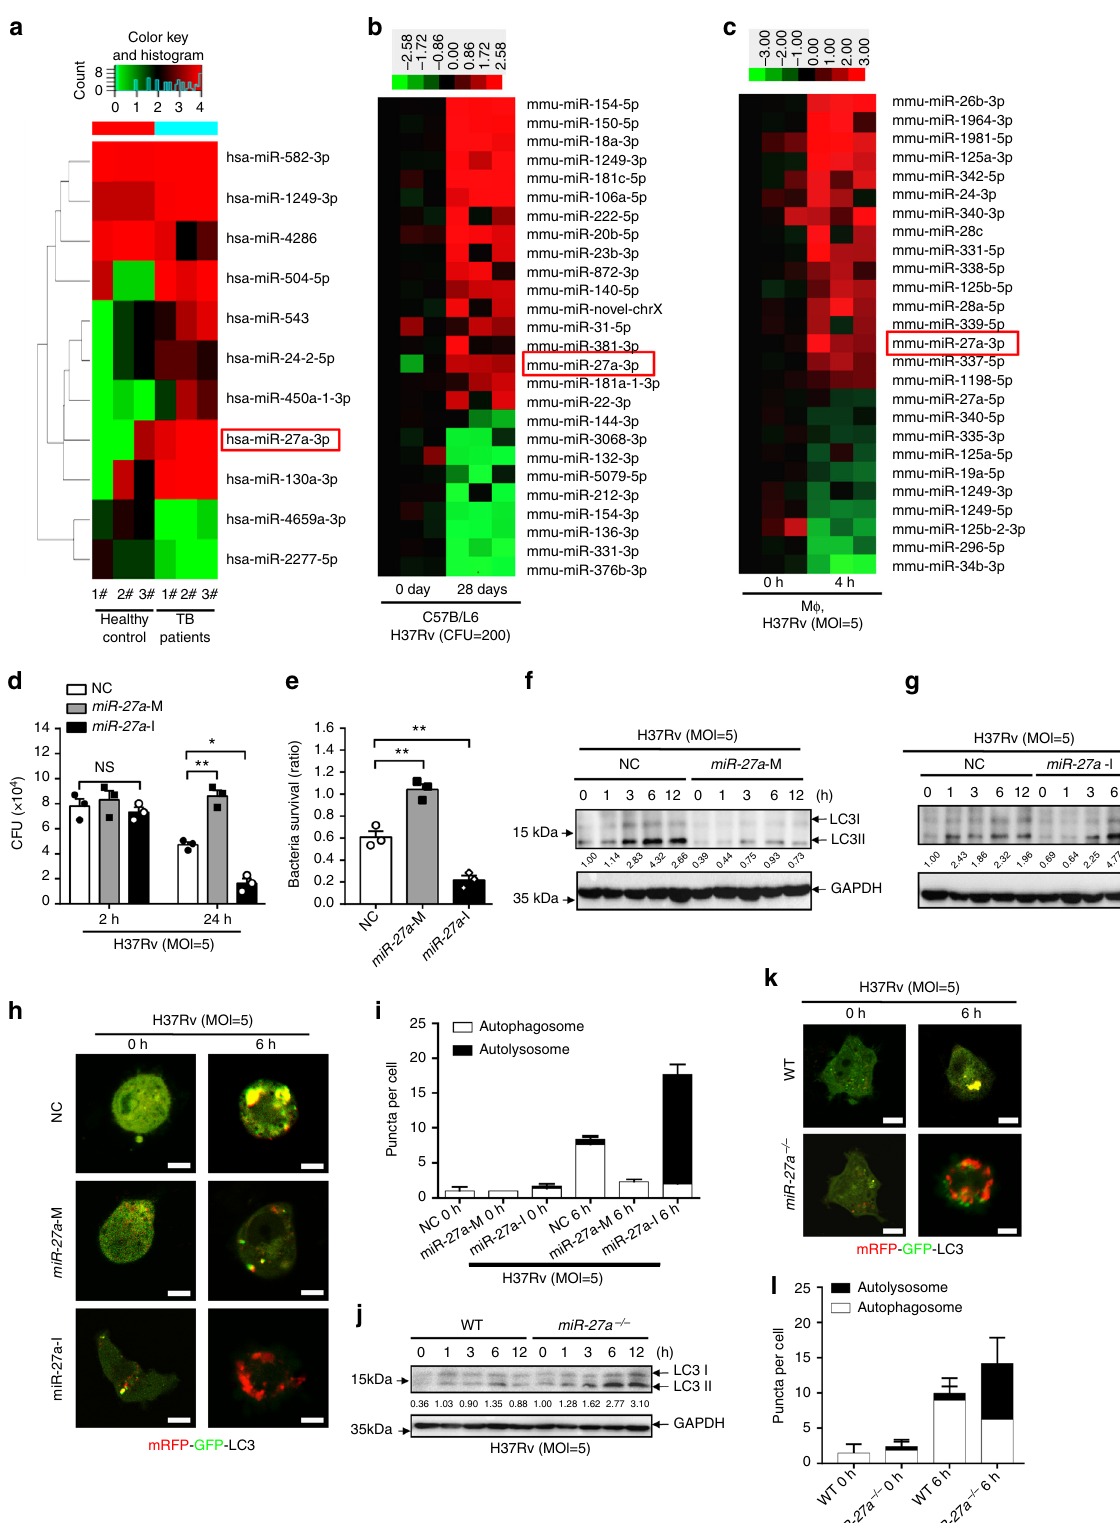
It has been reported that the intracellular survival of Mtb is controlled by autophagy 14 . To examine whether miR-27a enhances Mtb survival through autophagy, wild type (WT) or miR-27a -/- macrophages, or macrophages transfected with miR-27a mimic or negative control (NC) were fi rst pretreated with either Ba fi lomycin A1 (Baf A1) 34 , a vacuolar-ATPase